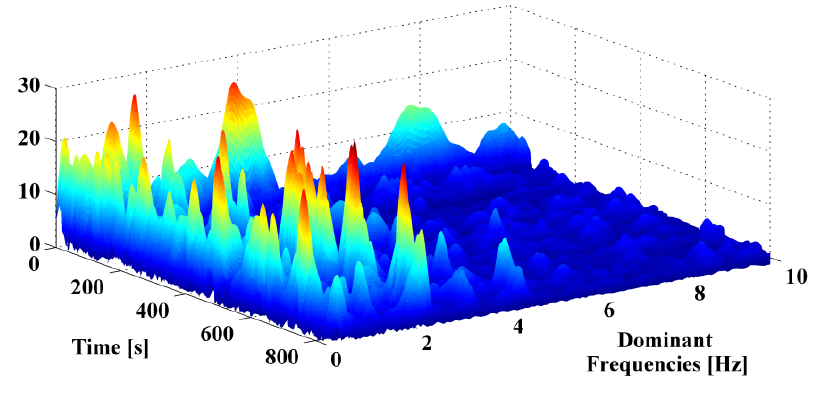
Figure 7. Time series of the spectrum of user hand motion when walking naturally with a handheld device. Dominant frequencies are observed in the range 0–5 Hertz and can be used to classify the motions of the hand and